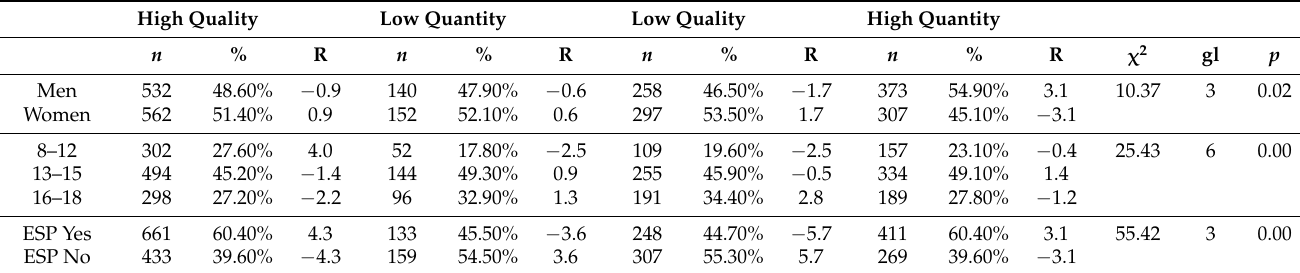
Table 5. Differences according to gender, age and extracurricular